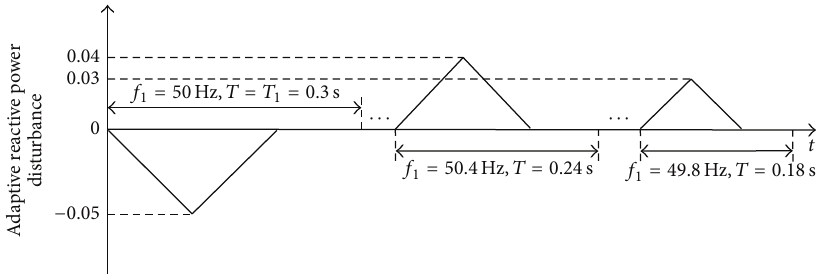
Figure 4: The adaptive and periodic disturbance with different values of 𝑓 1 .